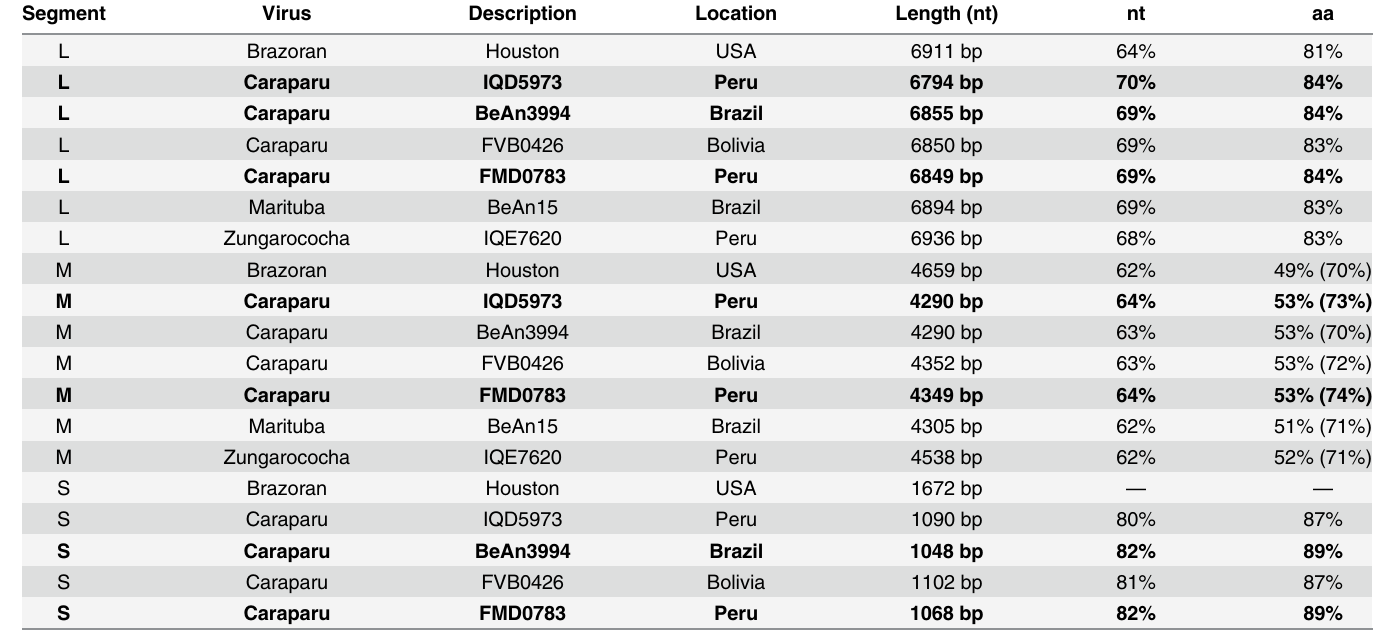
Table 2. Nucleotide and amino acid similarity to the most closely related Group C orthobunyavirus genomes. Values in parenthesis indicate % iden- tity calculated on segment M aligned regions without the highly polymorphic region located between positions 1500 – 2500.